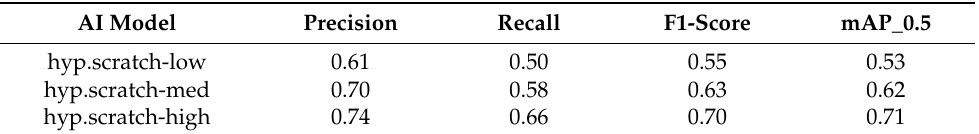
Table 2. The evaluation performance of YOLOv5x with three different hyperparameters and initial- ization